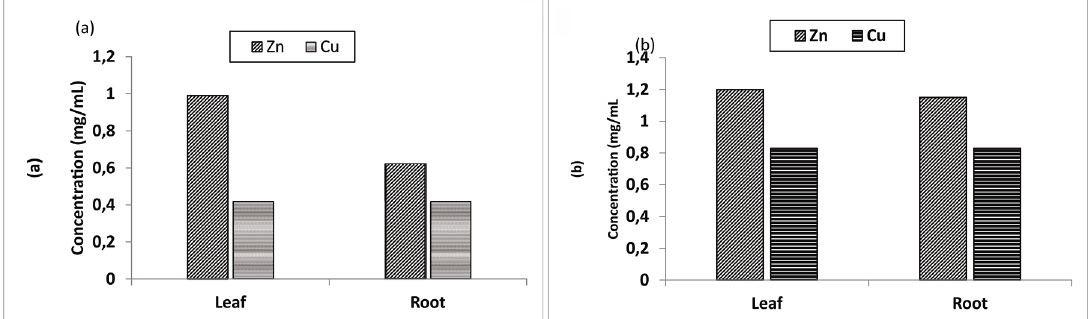
Figure 2. Accumulation of Zn and Cu in the dry biomass at concentrations 1.0mg mL -1 (a) and 2.0 mg mL -1 (b).